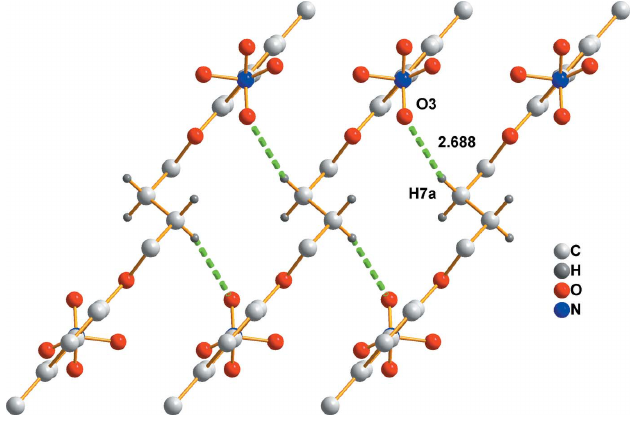
Figure 2 The chains generated by C7—H7 A (cid:2)(cid:2)(cid:2) O3 interactions (green dashed lines). H atoms not involved in these interactions have been